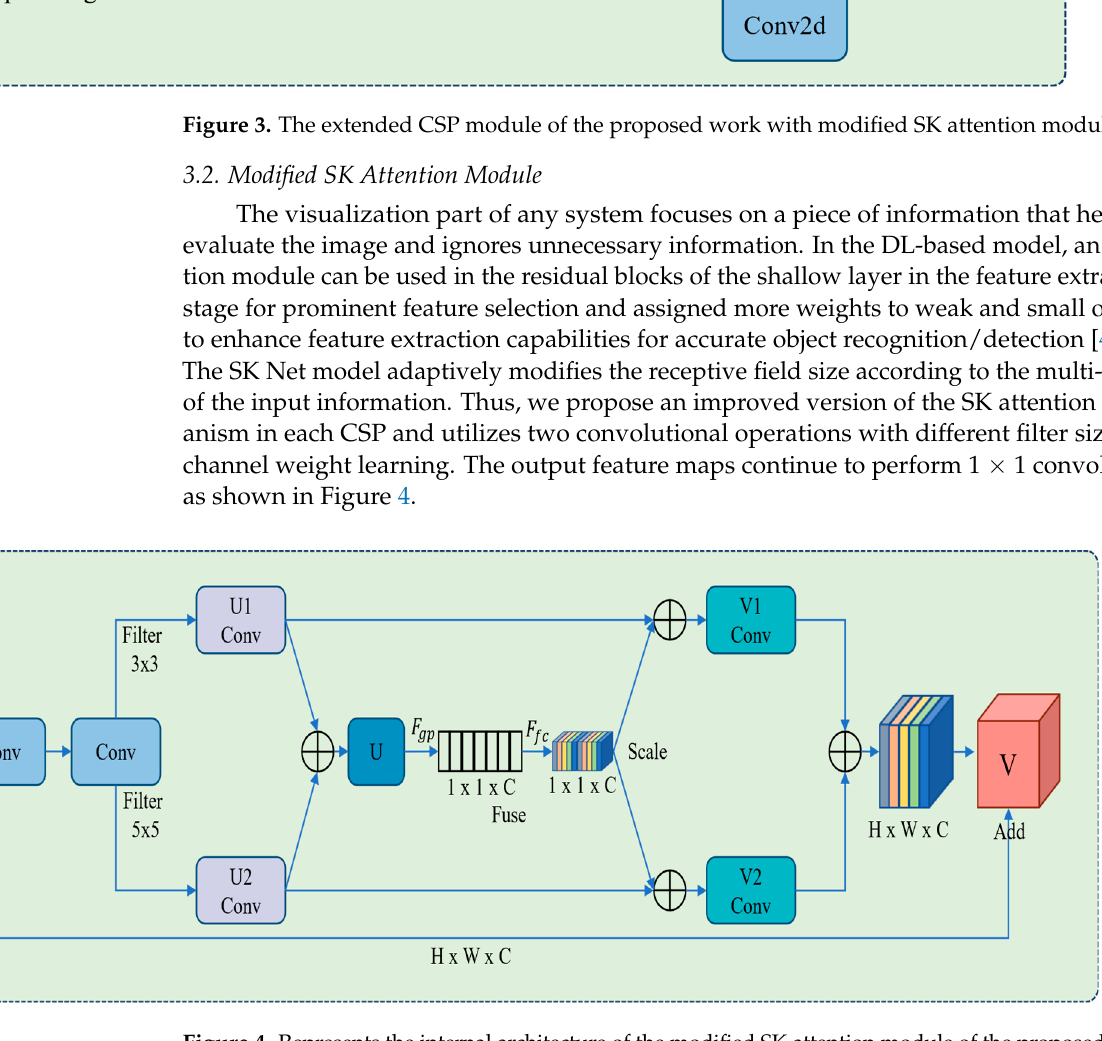
Figure 3. The extended CSP module of the proposed work with modified SK attention module.